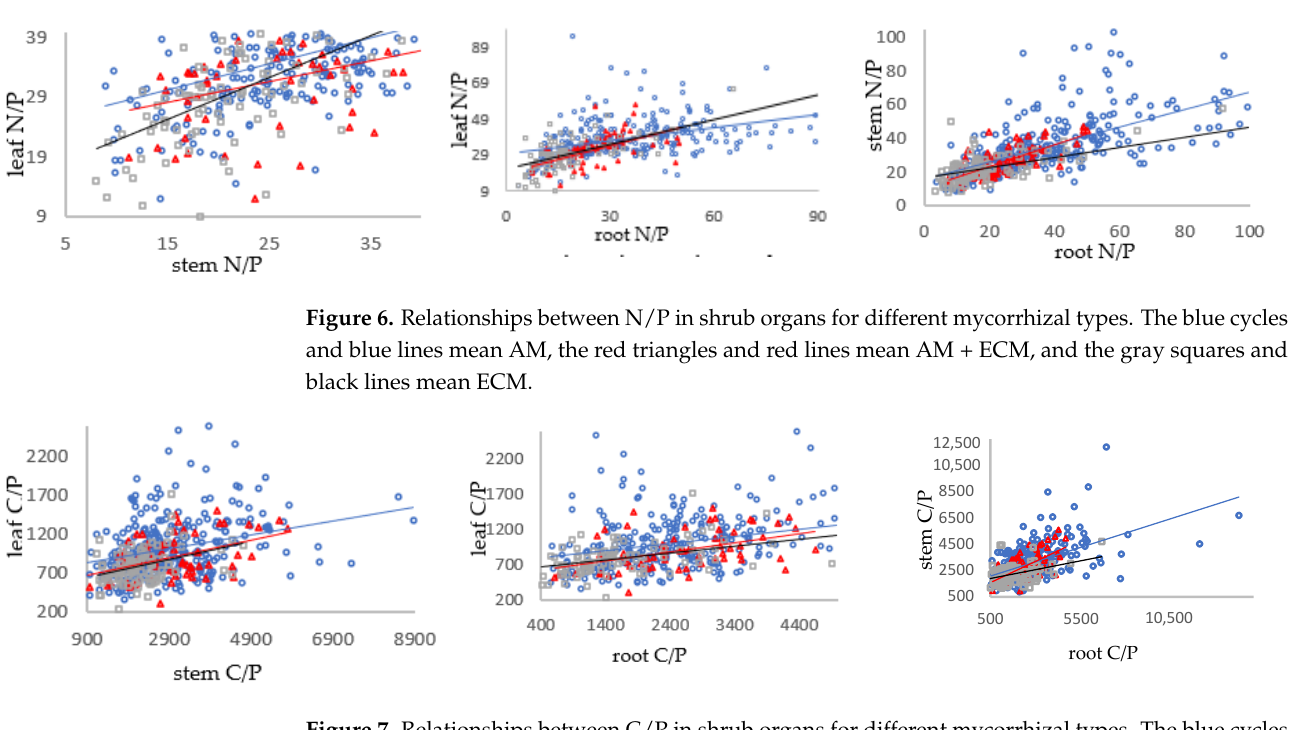
Figure 7. Relationships between C/P in shrub organs for different mycorrhizal types. The blue cycles and blue lines mean AM, the red triangles and red lines mean AM + ECM, and the gray squares and black lines mean ECM.